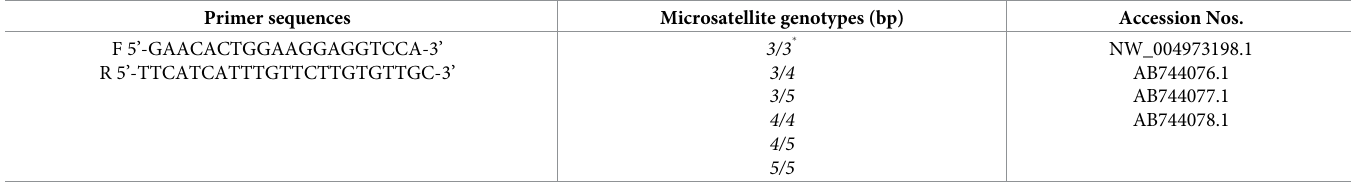
Table 1. The new primer set flanking the (TTTAT) 3-5 microsatellite located within the intron 6 of the LDHA gene. Primer